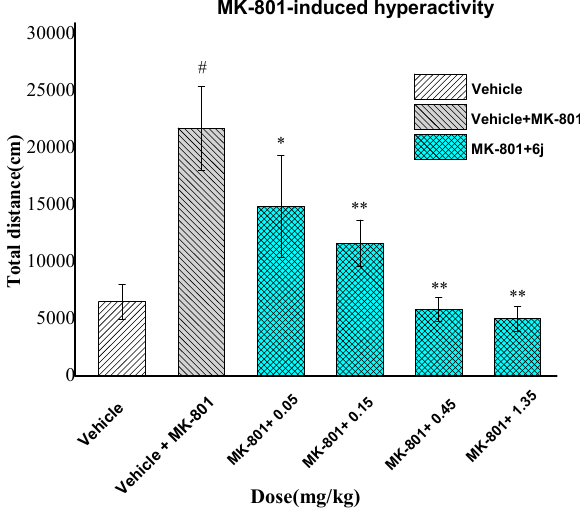
Figure 3. Effect of compound 6j on MK-801-induced hyperactivity in mice (10/group). The distance expressed as the means ± SEM. Statistical evaluation was conducted by two-way ANOVA followed by Tukey’s test for multiple comparisons. # p < 0.05 vs. vehicle treatment; ** p < 0.01 and * p < 0.05 vs. MK-801 treatment.